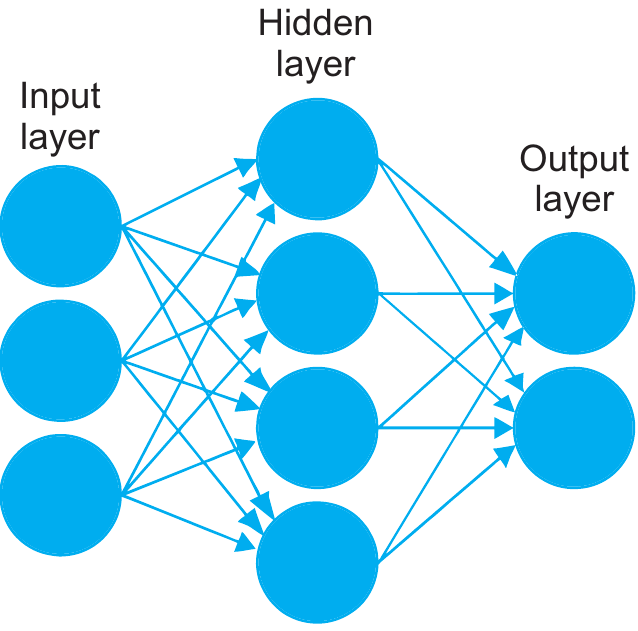
Figure 8. Typical ANN